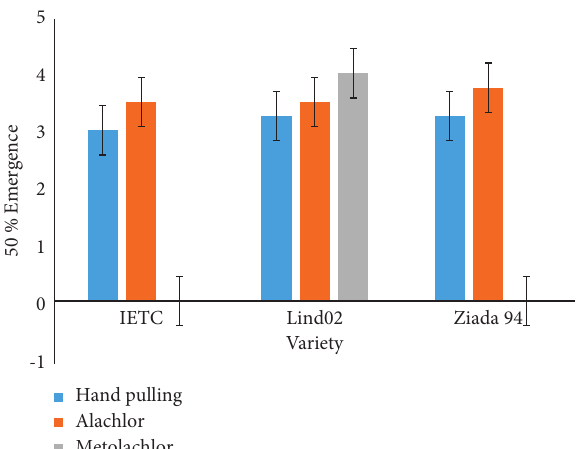
Figure 1: Effect of preemergence herbicides on 50% emergence of different sesame varieties. Errors bars represent error bars at p < 0 .